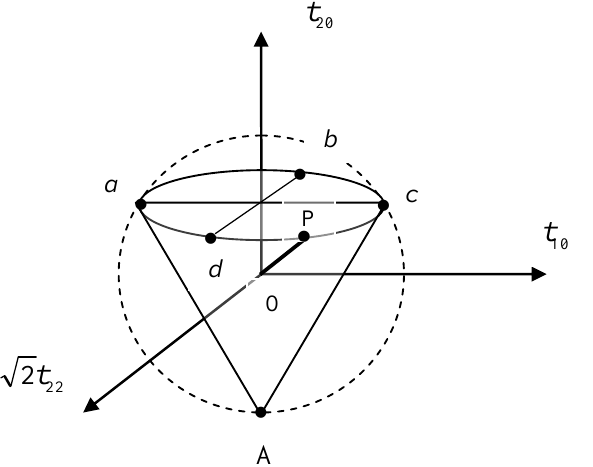
Figure 12. Admissible values of combined vector and tensor polarization states are defined by the point P in a cone inserted into a sphere with the radius 2 . The cross-section aAc of the cone is the equilateral triangle.